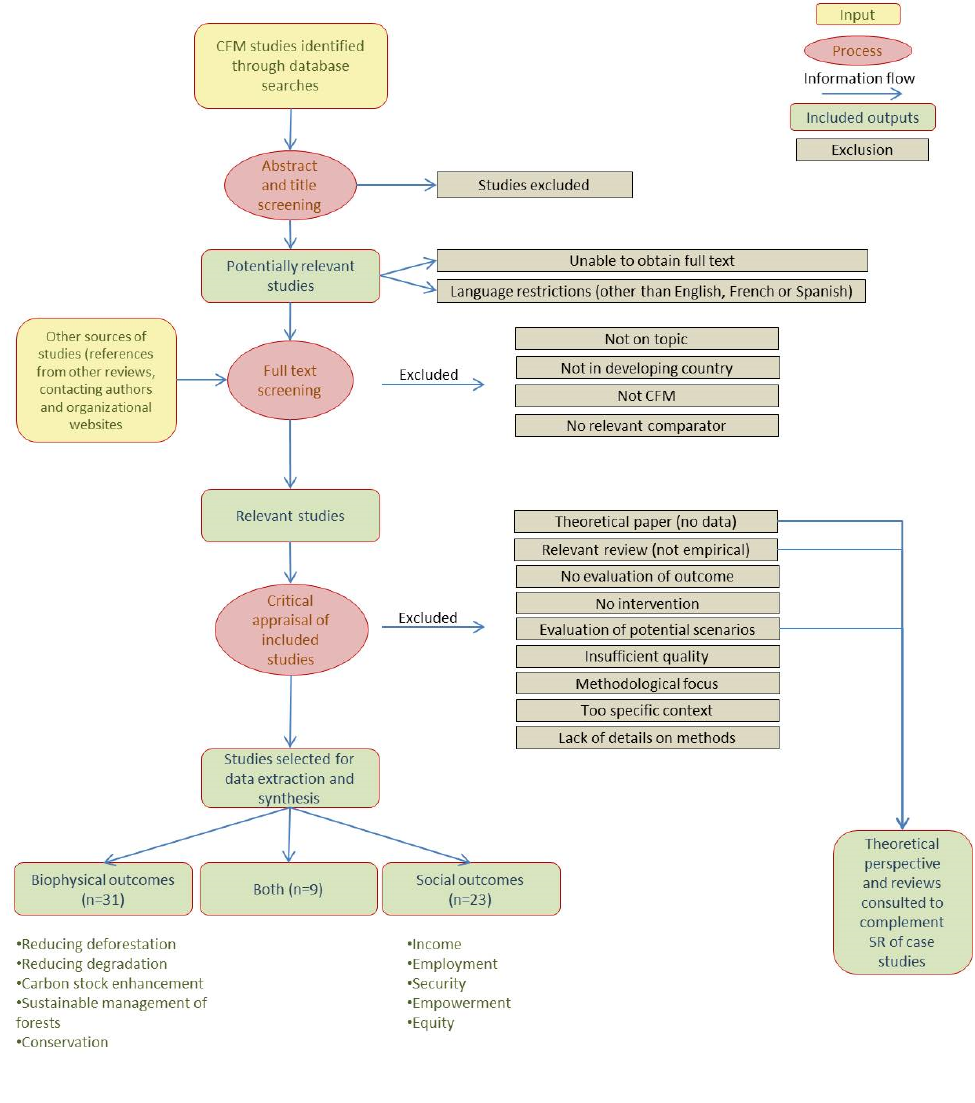
Figure 3. Diagram of the selection and filtering process for the systematic review.